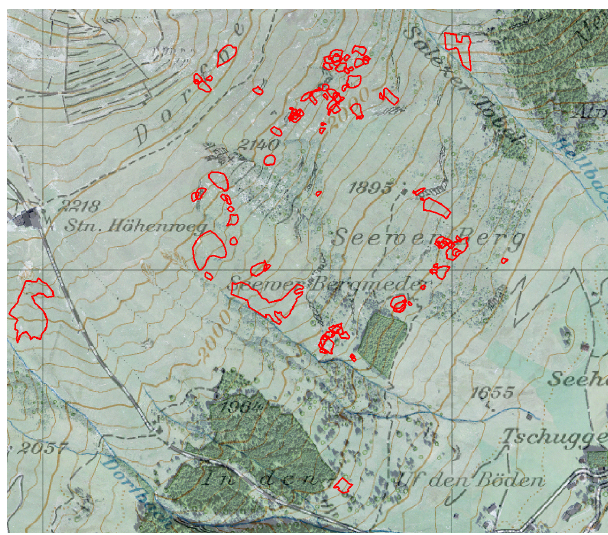
Figure 2. Glide-snow avalanche release zones on the Dorfberg, Davos (Swissimage © , DV 033594, 2013).